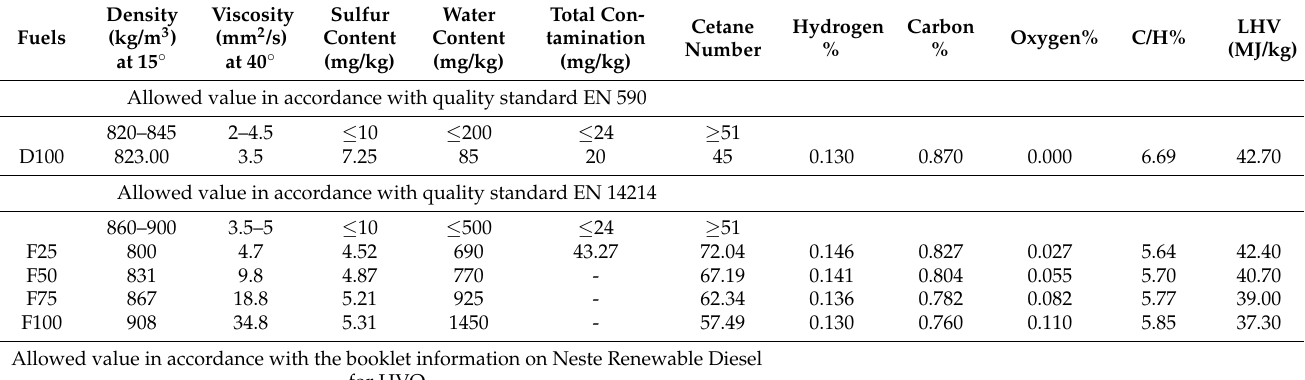
Table 1. Physicochemical properties of the analyzed